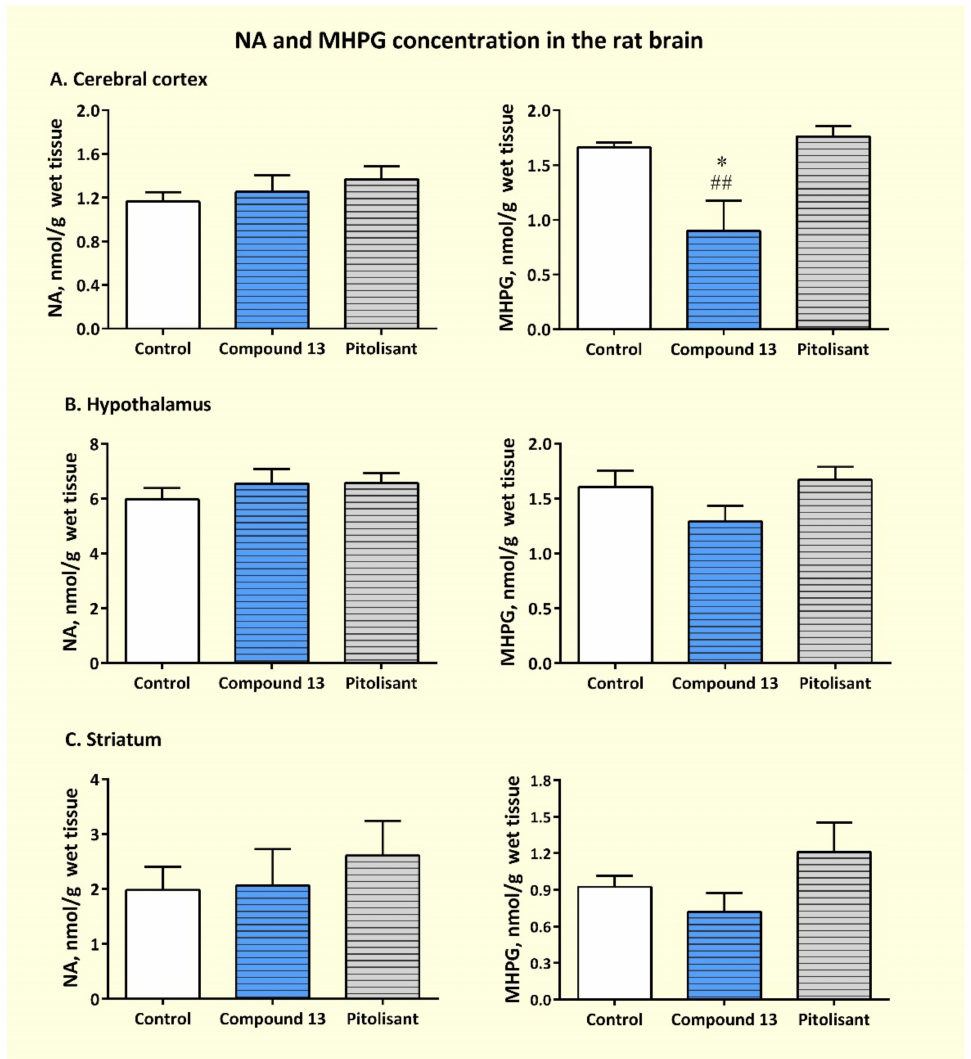
Figure 10. Concentrations of NA and MHPG in brain regions of rats sub-chronically treated with com- pound 13 and pitolisant (NA, noradrenaline; MHPG, 3-Methoxy-4-hydroxyphenylglycol). The drugs (both in a dose of 3 mg/kg of body mass) were injected subcutaneously for 6 consecutive days. Values are expressed as nanomoles per gram wet weight and are means ± SEM (n = 7–8). One-way ANOVA and Tukey’s multiple comparisons test: * vs. control, # vs. pitolisant. One symbol means p < 0.05, while two symbols p <